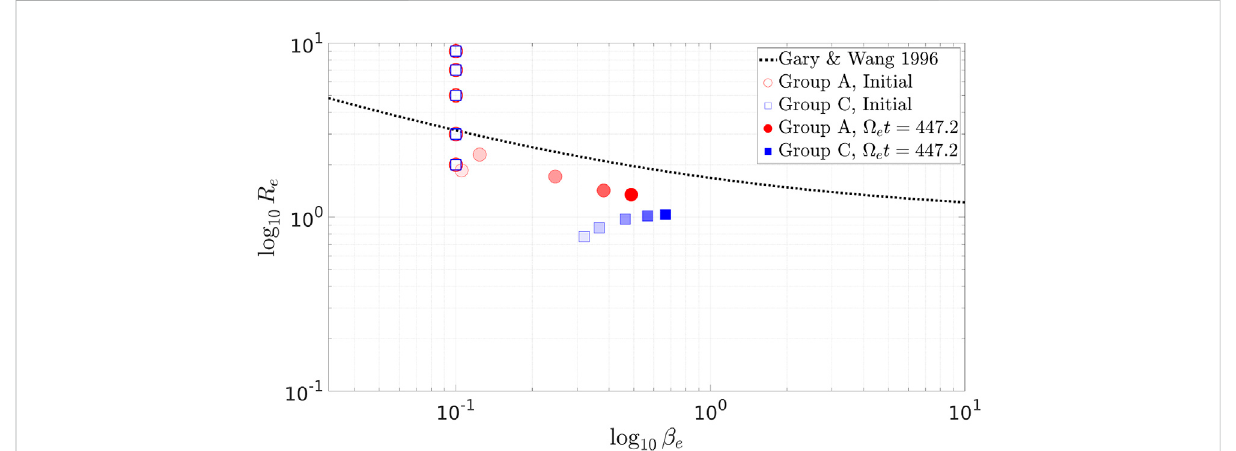
FIGURE 4 Average electron temperature anisotropy R e v. s. β e at Ω e t = 0 and at Ω e t ≈ 447.2 for Group A and Group C. The initial anisotropies are shown as transparent circle for Group A and transparent square for Group C, respectively. The fi nal anisotropies for Run A1 through A5 are color circles with increasingly dark shades, and that for Run C1 through C5 are color squares with increasingly dark shades. The upper bound predicted by Eq. 6 is shown as the dotted line.